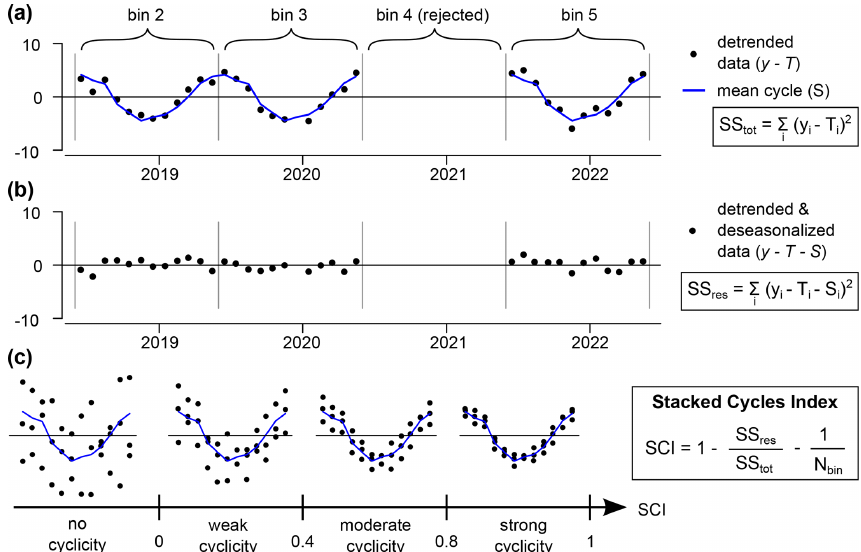
Figure 4. The Stacked Cycles Index (SCI ≤ 1) quantifies the strength of the cyclicity associated with the period of a bin. The long-term trend (mean-based) is first removed to compute the total sum of squares (a) . Then the cyclic component (mean-based) is also removed to compute the sum of squared residuals (b) . SCI is the coefficient of determination minus N − 1 with N bin the number of accepted bins (here, N bin = 3, c